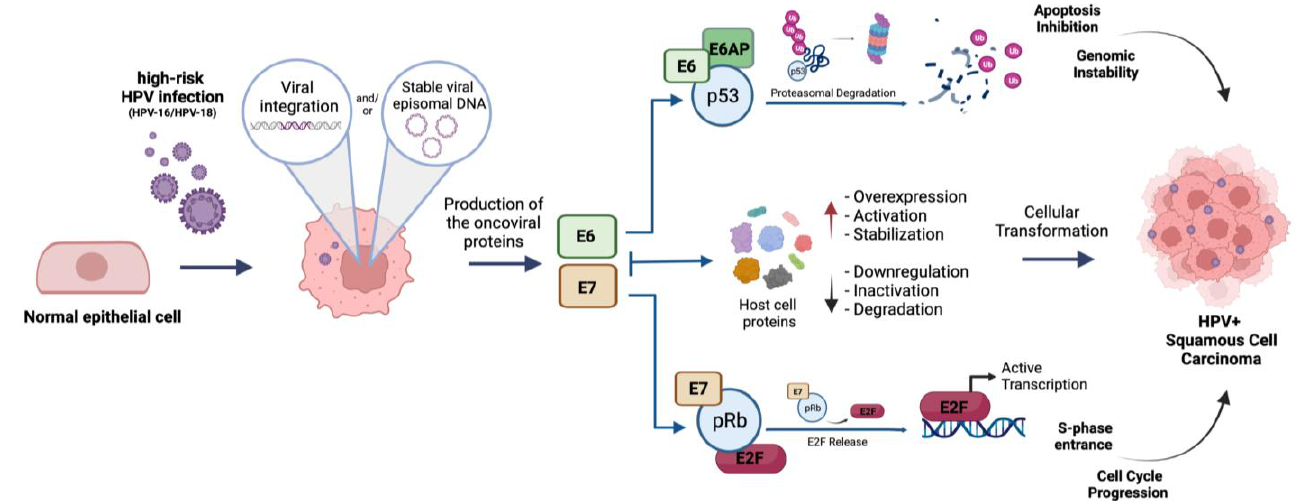
Figure 1. Schematic representation of hr-HPV (HPV16/18) mediated cellular transformation of infected epithelial cells. E6: oncoviral protein E6; E7: oncoviral protein E7; E6AP: ubiquitin ligase E6 associated protein; p53: tumor suppressor protein p53; pRb: oncosuppressor protein pRb; E2F: E2F-1 transcription factor. Created with BioRender.com.